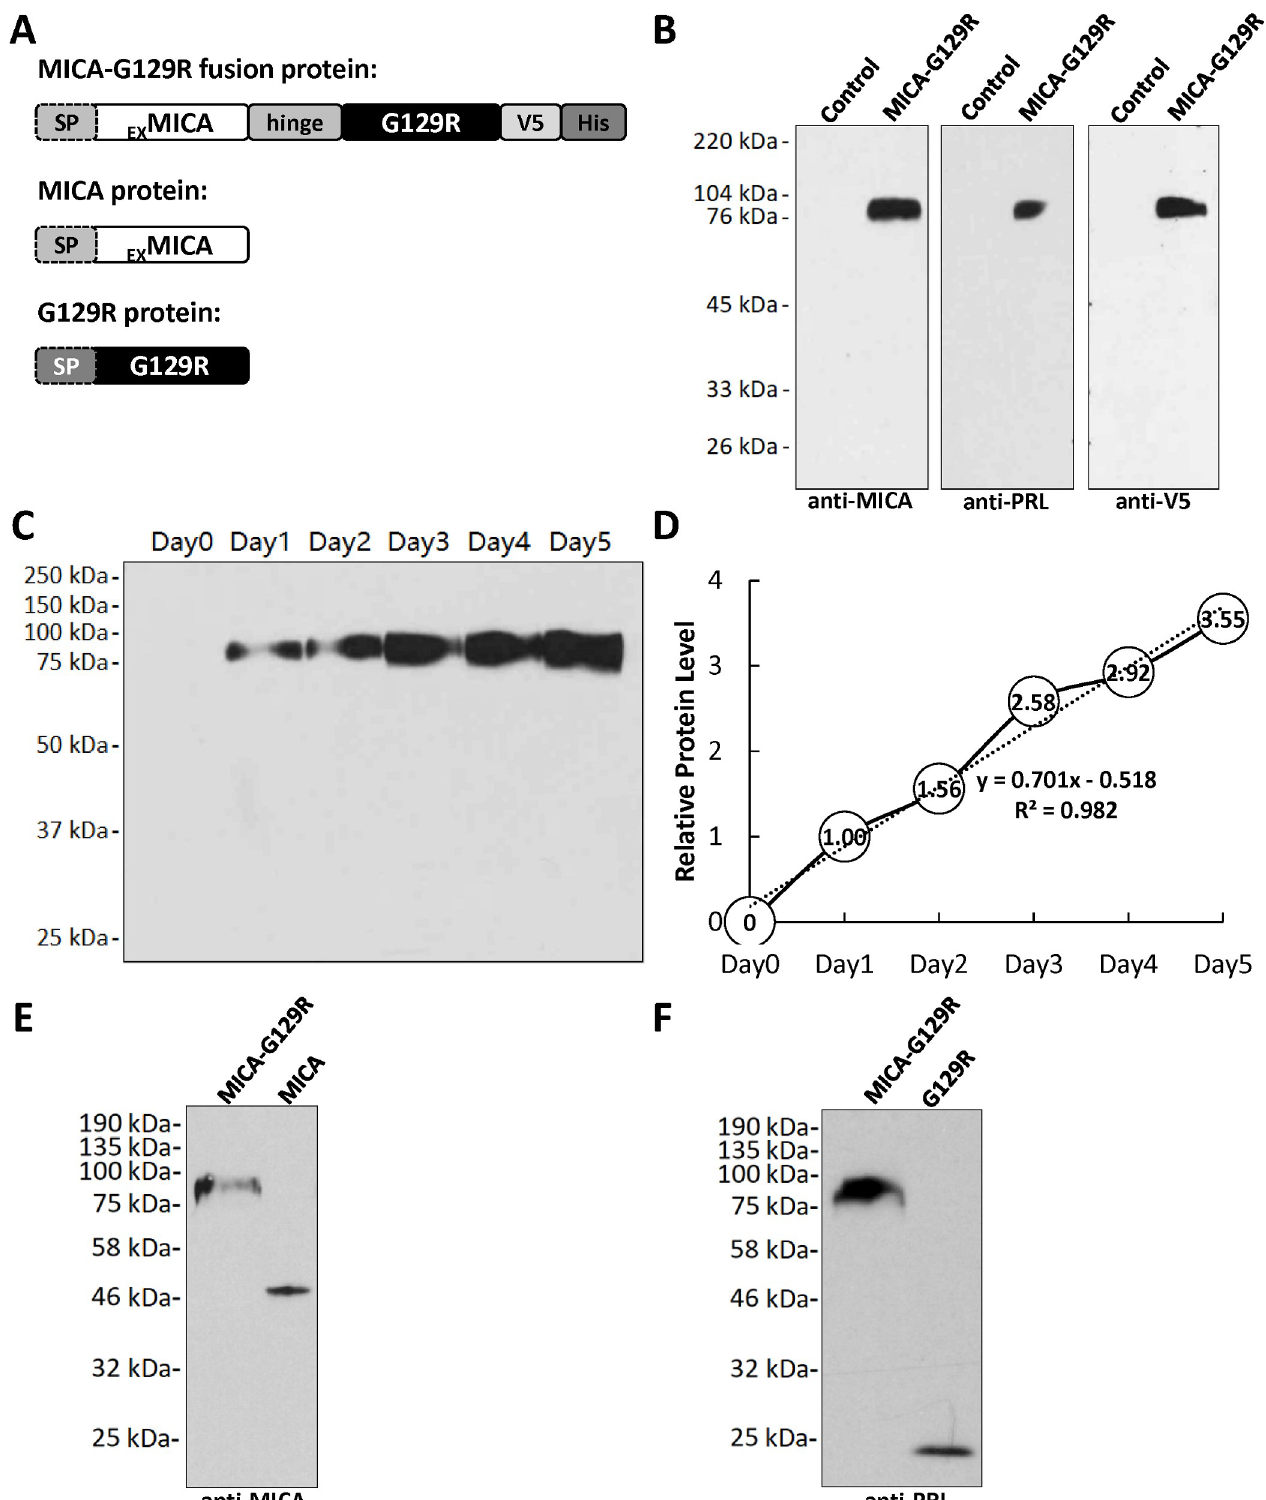
Fig 1. Expression of MICA-G129R fusion protein. A. Gene constructs of the MICA-G129R fusion protein, MICA protein and G129R protein. The gene sequences encoding the extracellular domain of MICA and G129R (without signal peptide), were cloned, linked together with a (GGGS) × 3 hinge and inserted into the expression vector. A V5 tag and a His tag were added to the 3’ end of the MICA-G129R sequence. The gene sequences of the extracellular domain of